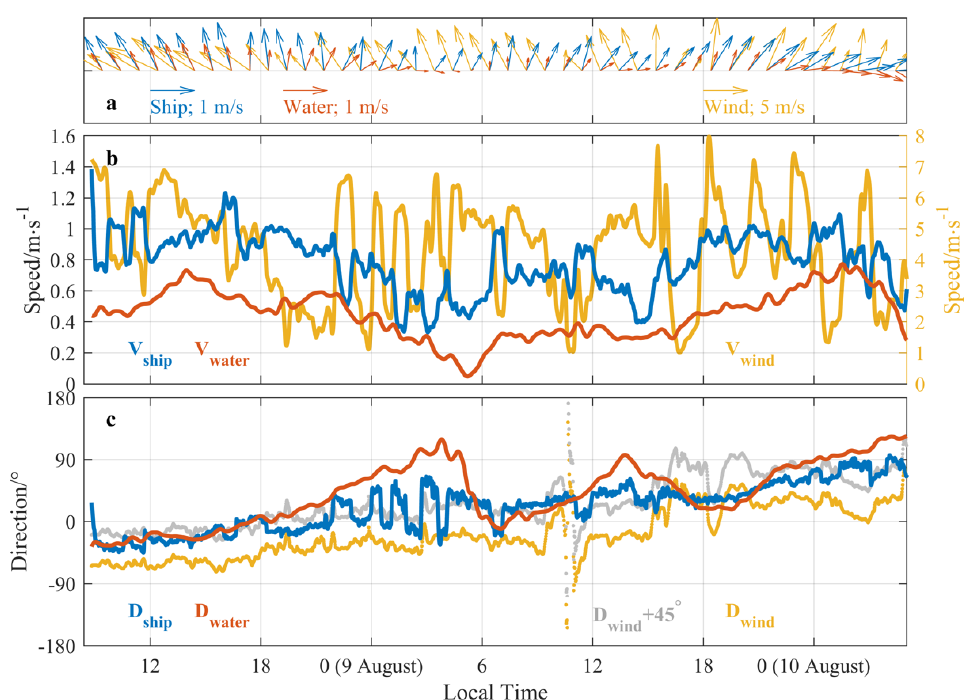
Figure 2. The drifting velocity of the R/V (blue arrows and lines), surface velocity (red arrows and lines) and the wind velocity (yellow arrows and lines). ( a ) Velocity (arrows). ( b ) Speed. ( c ) Direction. 0 ° (180°) means due north (south) and 90° ( − 90°) means due east (west). The gray lines indicate wind direction plus 45°.